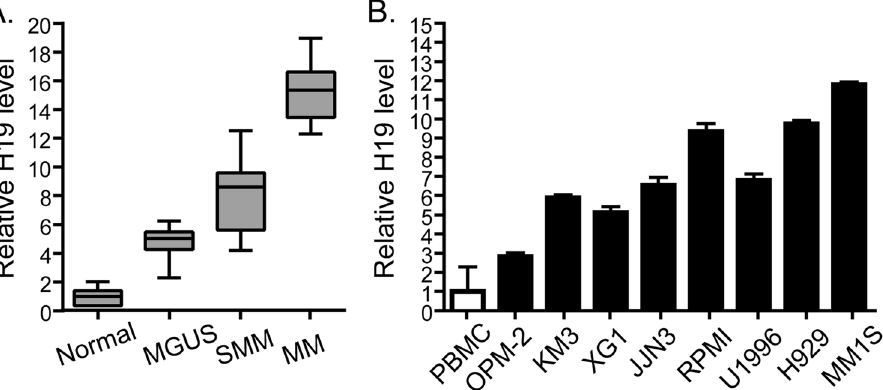
Figure 1. Increased expression of H19 in both MM bone marrow and cell lines. ( A ) H19 expression in bone marrow of MM patients compared with patients with MGUS, SMM and normal controls (three non-tumor patients who received femoral heads excision and were matched by gender and age). ( B ) H19 expression in nine MM cell lines compared with normal control peripheral blood mononuclear cells (PBMC) pooled from 3 healthy individuals. All the data were processed using 2 −ΔΔ CT method and normalized to GAPDH